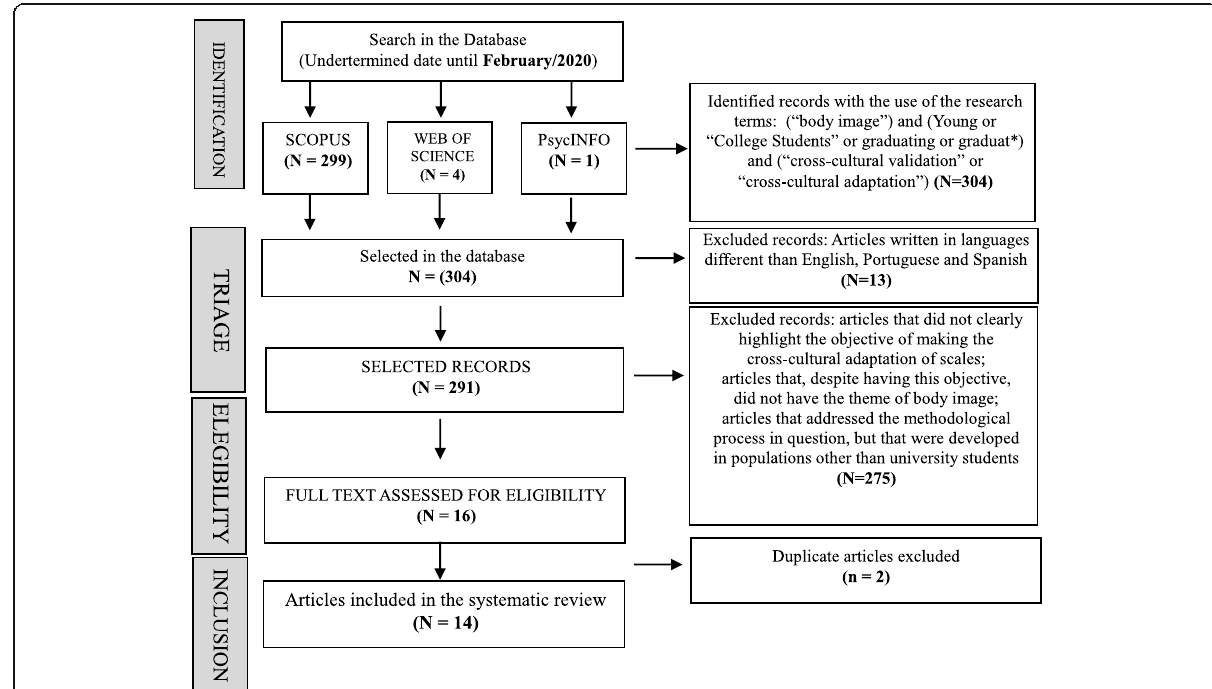
Fig. 1 Flowchart presenting the review of the systematic process of identification and selection of articles. Source: The author,